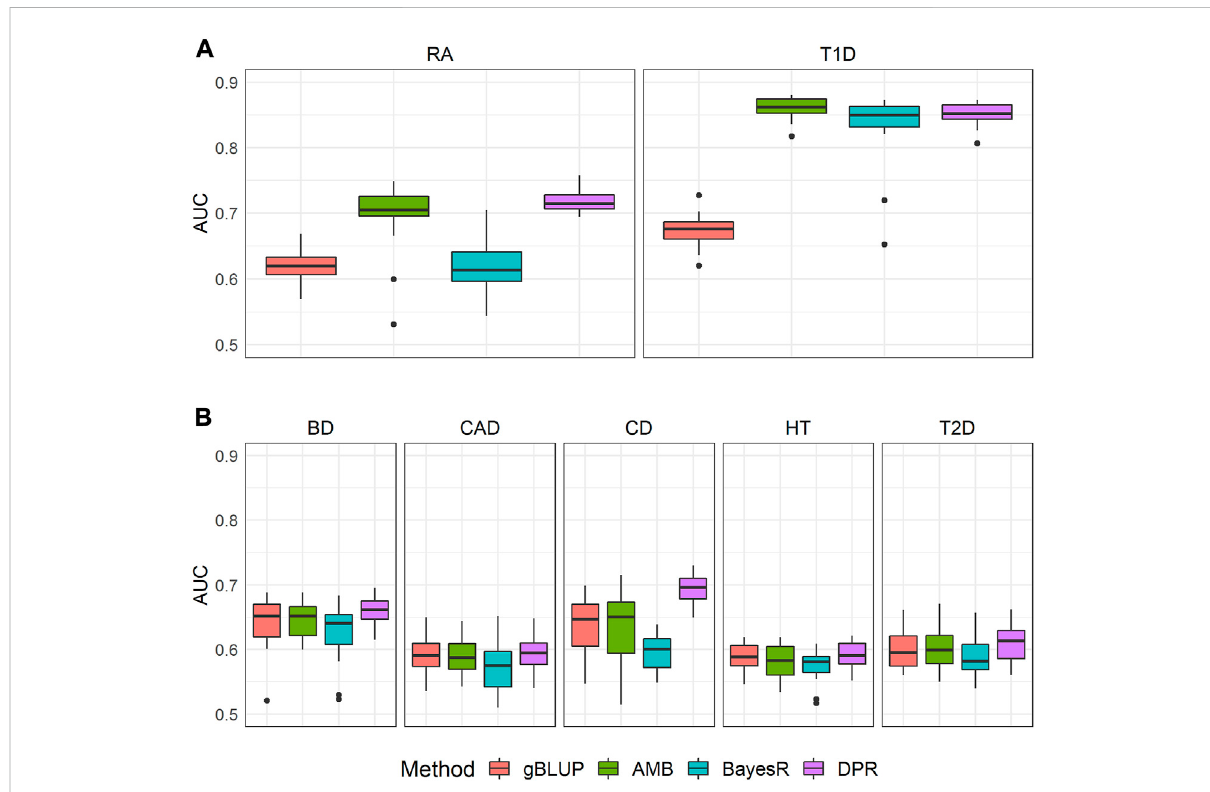
FIGURE 2 The area under the curve (AUC) for seven diseases in WTCCC. CD: Crohn ’ s disease; RA: Rheumatoid arthritis; T1D: Type 1 diabetes; BD: Bipolar disease; CAD: Coronary artery disease; HT: Hypertension; T2D: Type 2 diabetes. Methods include genomic best linear unbiased prediction (gBLUP), adaptive MultiBLUP (AMB), the latent Dirichlet process regression (DPR) and BayesR (A) This group included T1D and RA, where Manhattan plots suggested dense and spiked signals at the genome-wide signi fi cancelevel (i.e., p < 5 × 10 – 8 ) (B) This group included BD, CAD, CD, HT and T2D, where their Manhattan plots indicated only few SNPs achieved signi fi cance at a suggestive genome-wide signi fi cance level (i.e., p < 5 × 10 – 6